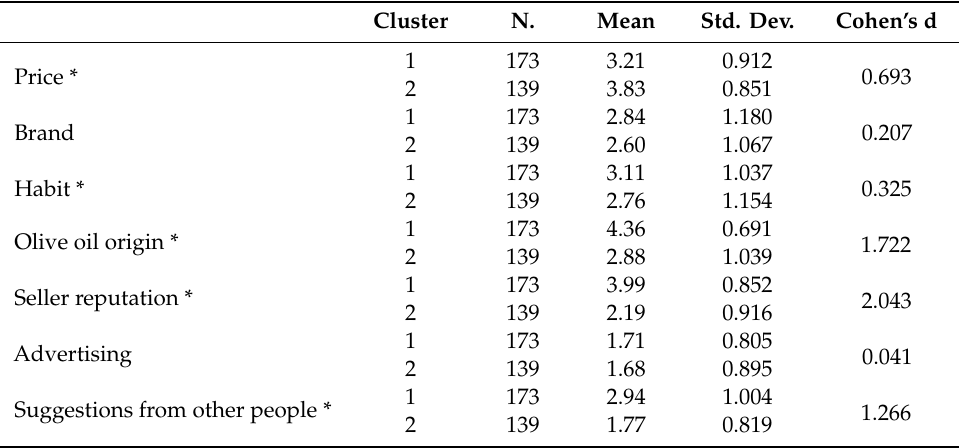
Table 4. Factors considered in the purchase of olive oil per cluster of belonging. Cluster N. Mean Std.